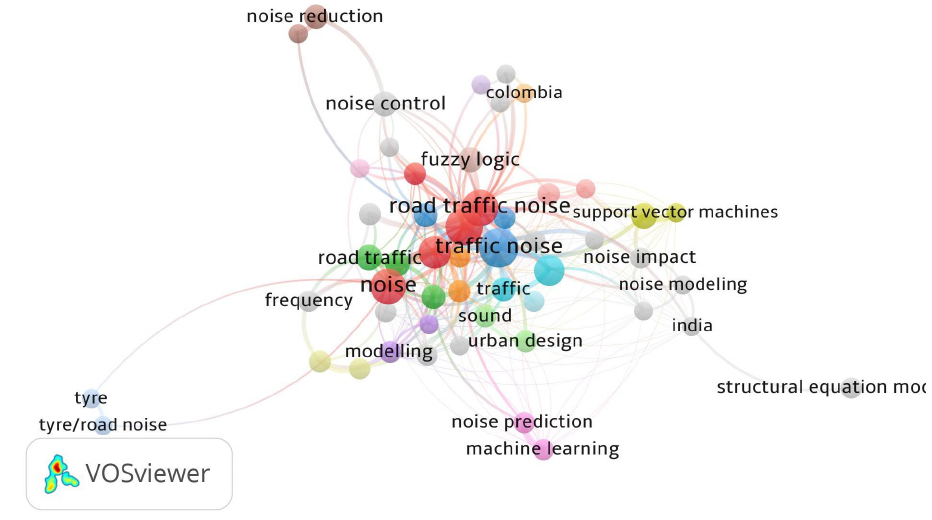
Figure 5: Network visualization (Keyword, co-occurrence, fractional